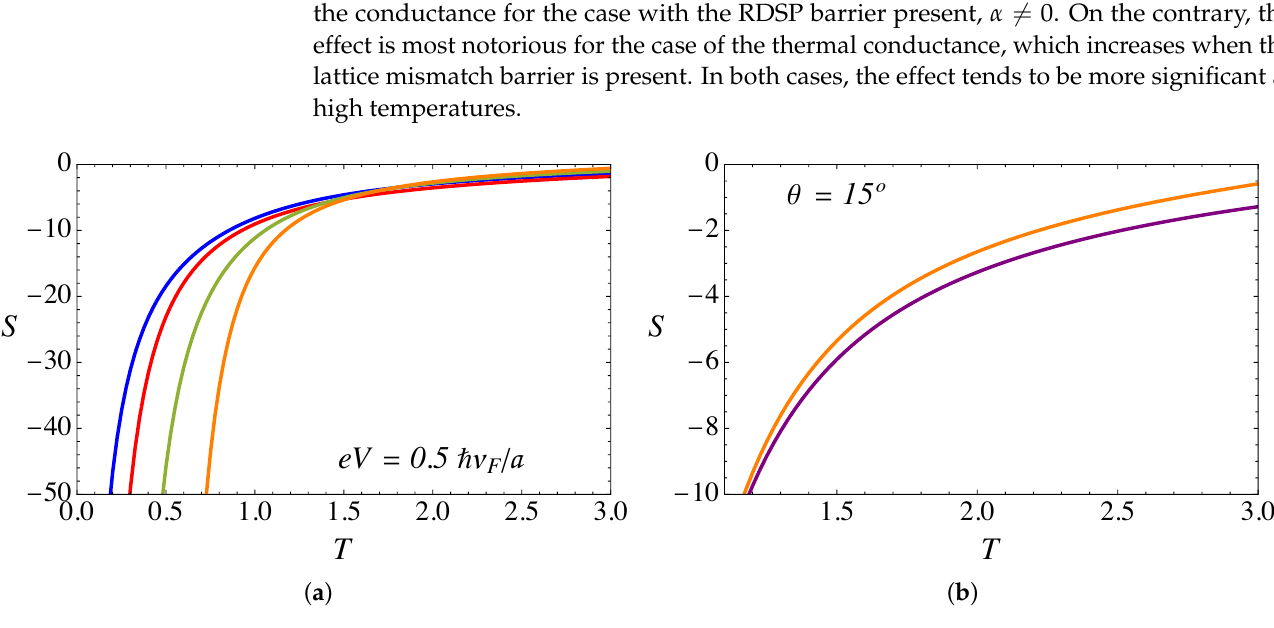
Figure 11. (Color online) ( a ) Seebeck coefficient (in units of k B / e ) computed from the analytical expression in Equation (17) as a function of temperature T (in units of ¯ hv F / k B a ). The plot is for fixed B 0 a 2 = 25 ˜ φ 0 , a bias eV = 0.5 ¯ hv F / a , and α = 3 π /4. The blue line corresponds to θ = 0 ◦ , red is for θ = 5 ◦ , green is for θ = 10 ◦ and the orange line corresponds to θ = 15 ◦ . ( b ) Comparison of the Seebeck coefficient for θ = 15 ◦ : the purple line is for α = 0 whereas the orange line is for α = 3 π